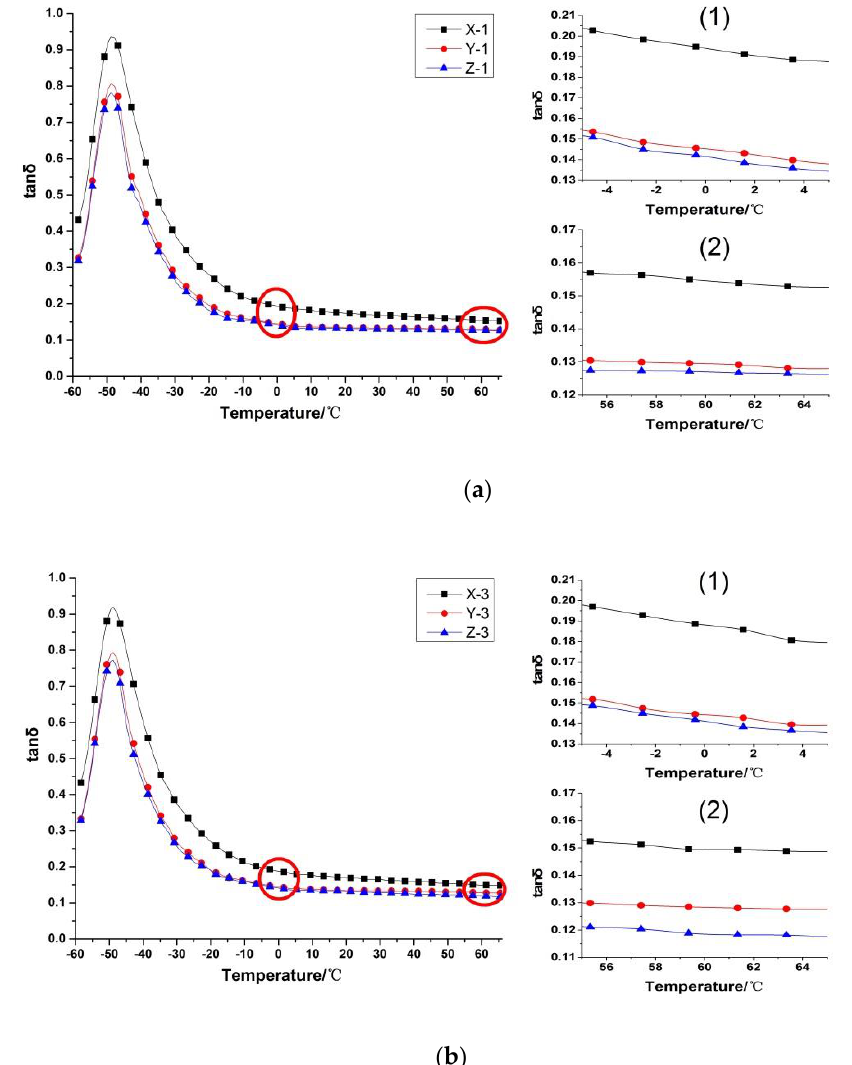
Figure 9. Tan δ -T Curve of vulcanizate: ( a ) Tan δ -T curve of vulcanizate when the screw speed is 10 rpm, 1 and 2 are magnified graphs of curves around 0 ◦ C and 60 ◦ C, respectively; ( b ) Tan δ -T curve of vulcanizate when the screw speed is 30 rpm, 1 and 2 are magnified graphs of curves around 0 ◦ C and 60 ◦ C, respectively.